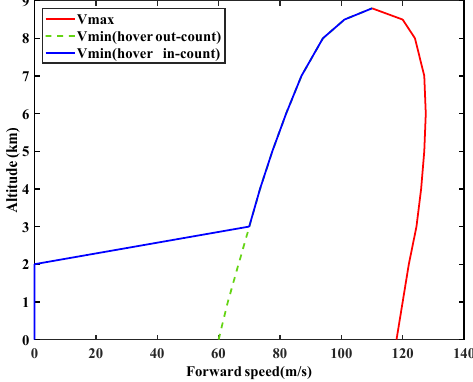
Figure 27. The flight envelope of the retrofit. According to the set working goal, the rotor root angle is 75° at 5 km altitude as a cruise state in 36 0 km/h forward speed and η reaches 0.72. The CFD calculation shows that all flight performances reach goal values. In the calculation, the maximum takeoff weight of the whole aircraft is set and the slipstream effect between the VDDF and the airframe is considered. Figure 28 gives a view of the eventually designed retrofit.